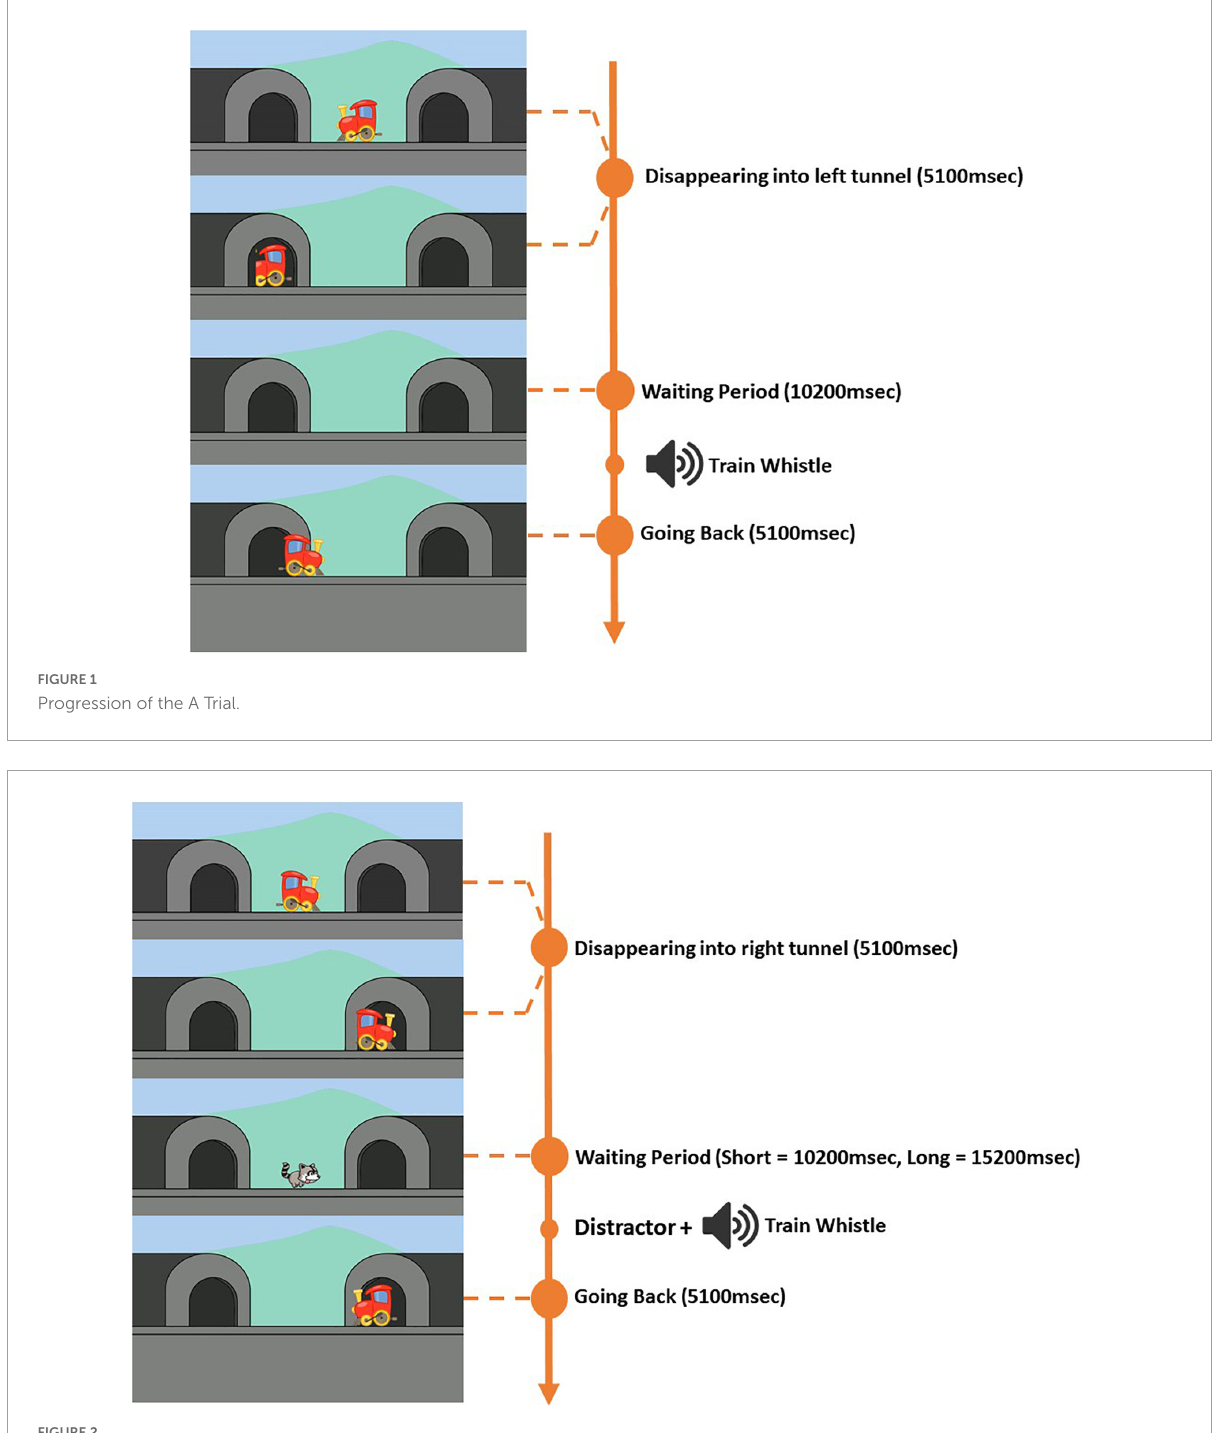
As for the “B” trials ( Figure 2 ), there were two trial types, one with a shorter waiting period (10,200 ms) and one with a longer waiting period (15,200 ms). In total, there were two